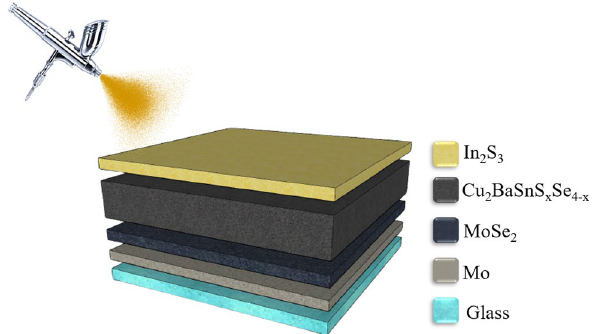
Figure 1. The scheme of the spray pyrolysis